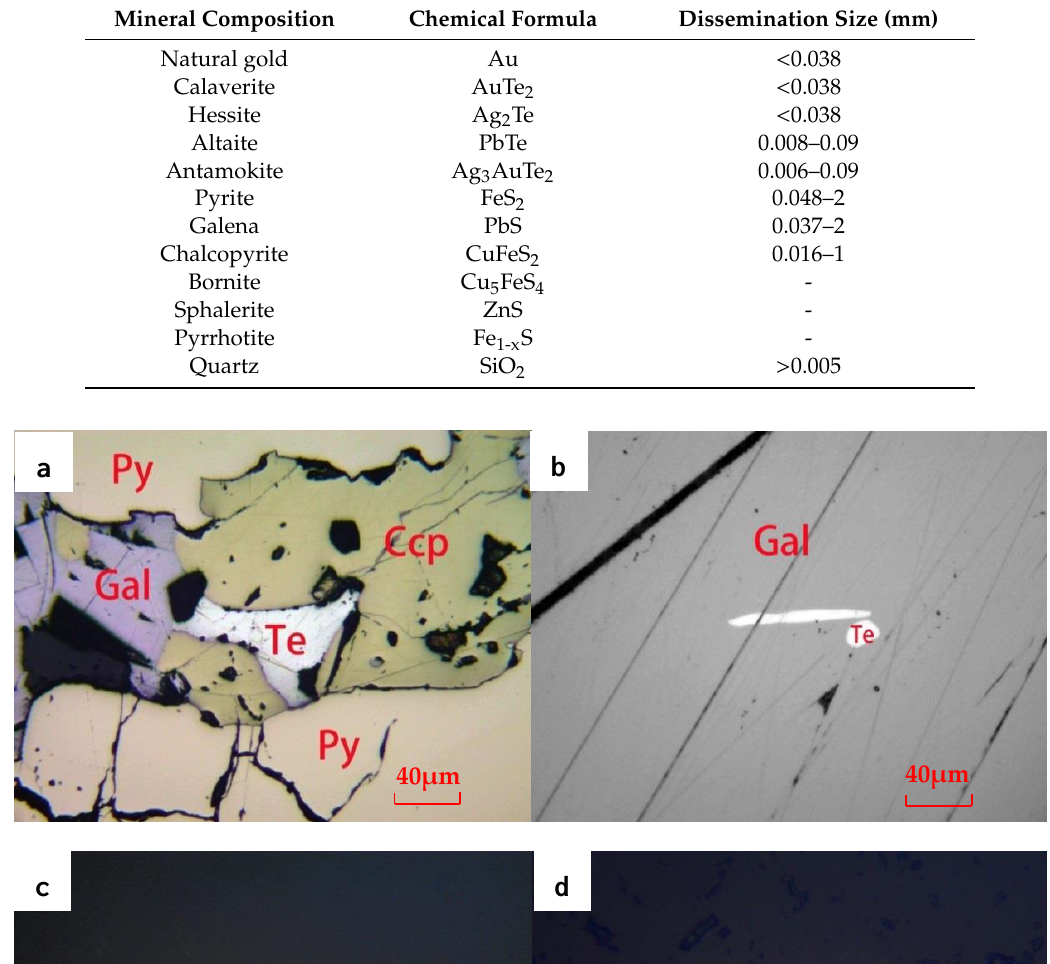
Table 1. Mineral composition, chemical formula, and dissemination size of the raw ore.